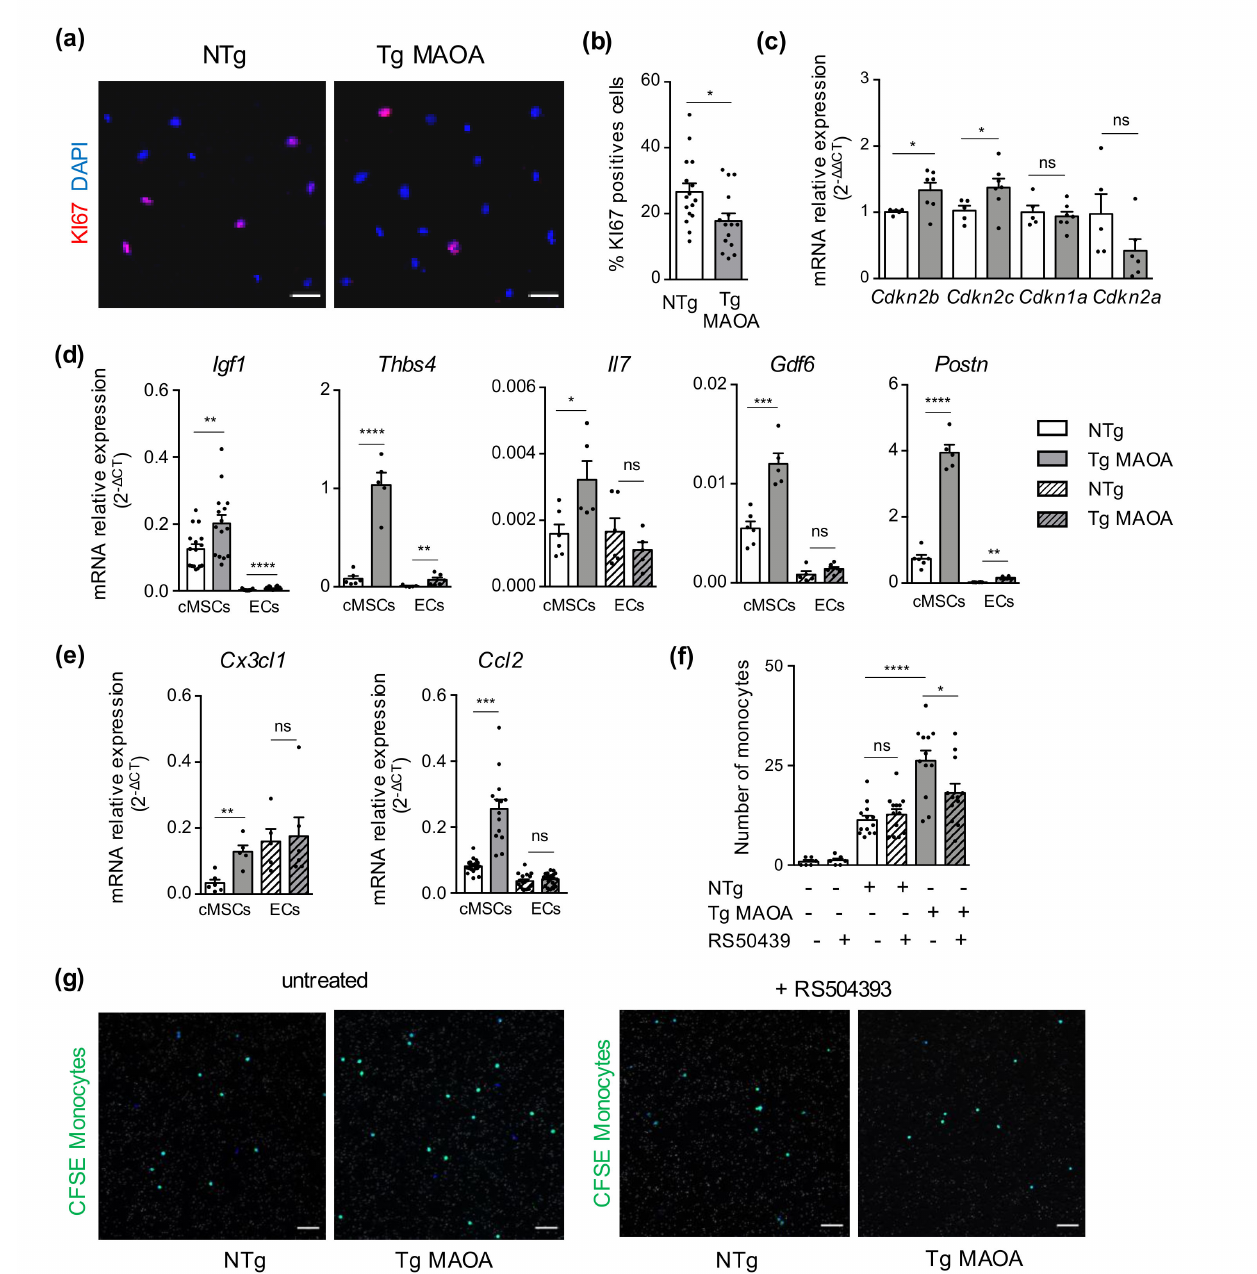
Figure 3. Oxidative stress induced premature senescence of cMSCs promotes CCR2-dependent monocyte recruitment. ( a , b ) Representative immunostaining of anti-Ki67 antibody (red; a ) and percentage ( b ) of positive cMSCs isolated from NTg ( n = 3) and Tg MAOA ( n = 4) mice. DNA stained with DAPI (blue). Scale bar, 50 µ m. ( c ) Relative mRNA expression of CDKIs from Tg MAOA cMSCs ( n = 7) compared to NTg ( n = 5). ( d , e ) mRNA expression of SASP factors ( d ) and of Ccl2 and Cx3cr1 chimiokines ( e ) by cMSCs and endothelial cells (ECs) isolated from NTg ( n = 6) and Tg MAOA ( n = 5) mice relative to gapdh gene expression. ( f , g ) Quantification and representative images of CFSE labelled monocytes pretreated or not with the CCR2 antagonist (RS 504393) at the lower part of the Fluoroblok insert after 2 h incubation with cMSCs from NTg ( n = 3) or Tg MAOA mice ( n = 4) in the bottom chamber compared to medium; nuclei: blue). Monocytes were pretreated (or not)). Nuclei were stained with DAPI (Blue), CFSE (green), DAPI (blue), pores: white. Scale bar, 50 µ m. Data are expressed as means ± SEM. * p < 0.05, ** p < 0.01, *** p < 0.001, **** p < 0.0001 vs. NTg